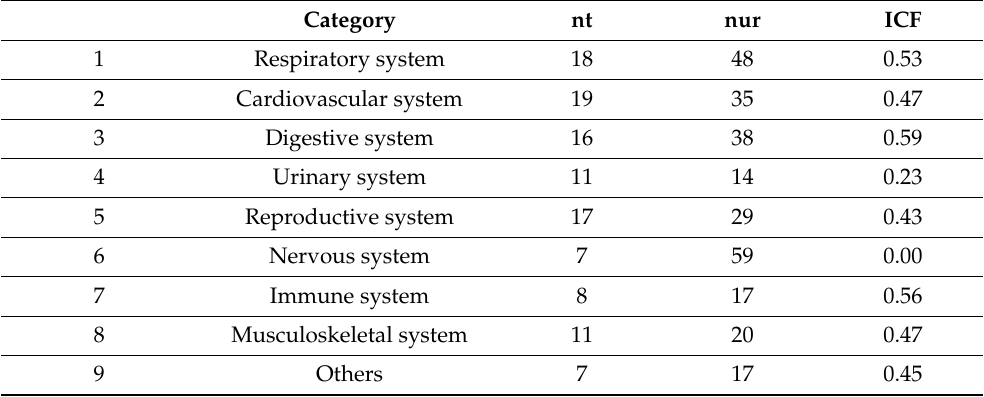
Table 4. ICF factor by diseases categories for East